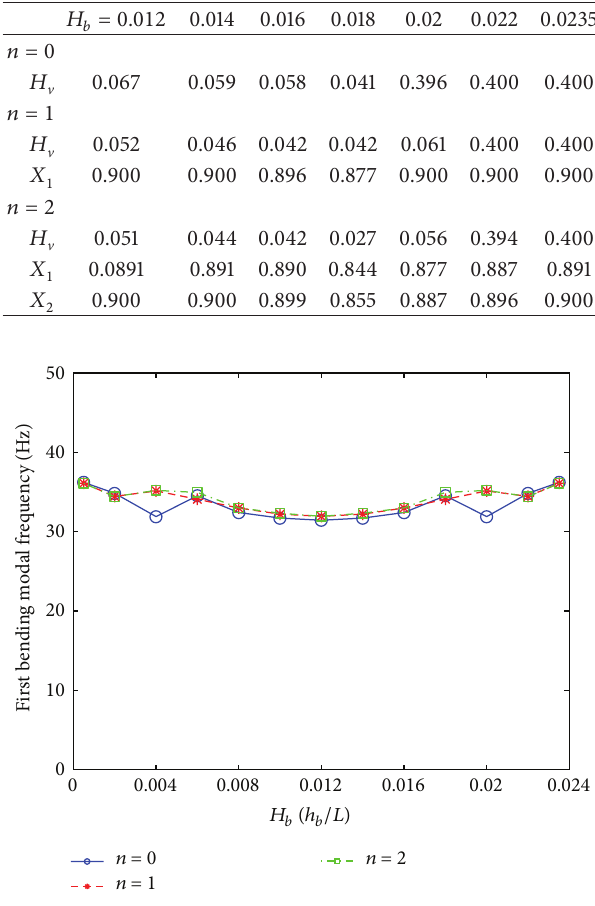
Figure 16: Natural frequency results for symmetric and asymmetric CLD configurations ( 𝐻 𝑏 + 𝐻 𝑐 = 0.024